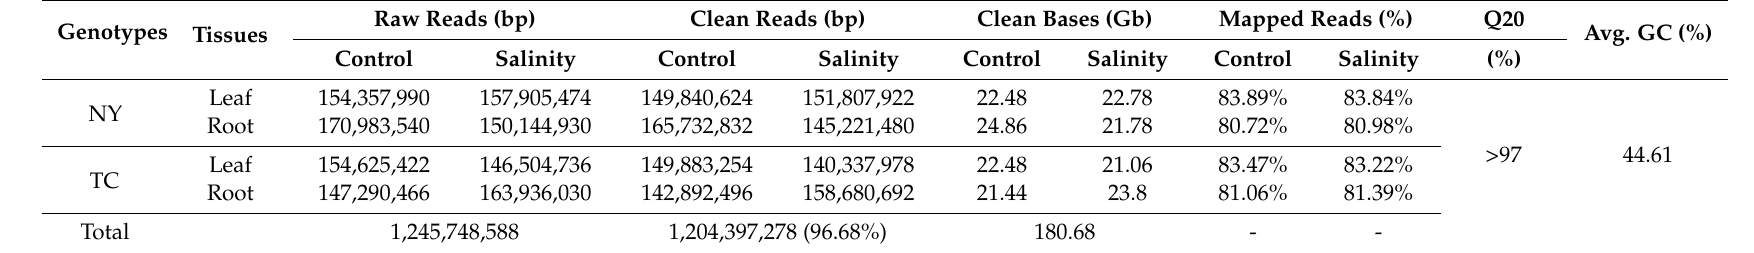
Table 1. Raw and clean data from 24 NY (salt sensitive) and TC (salt tolerant) jute transcriptomes. Genotypes Tissues